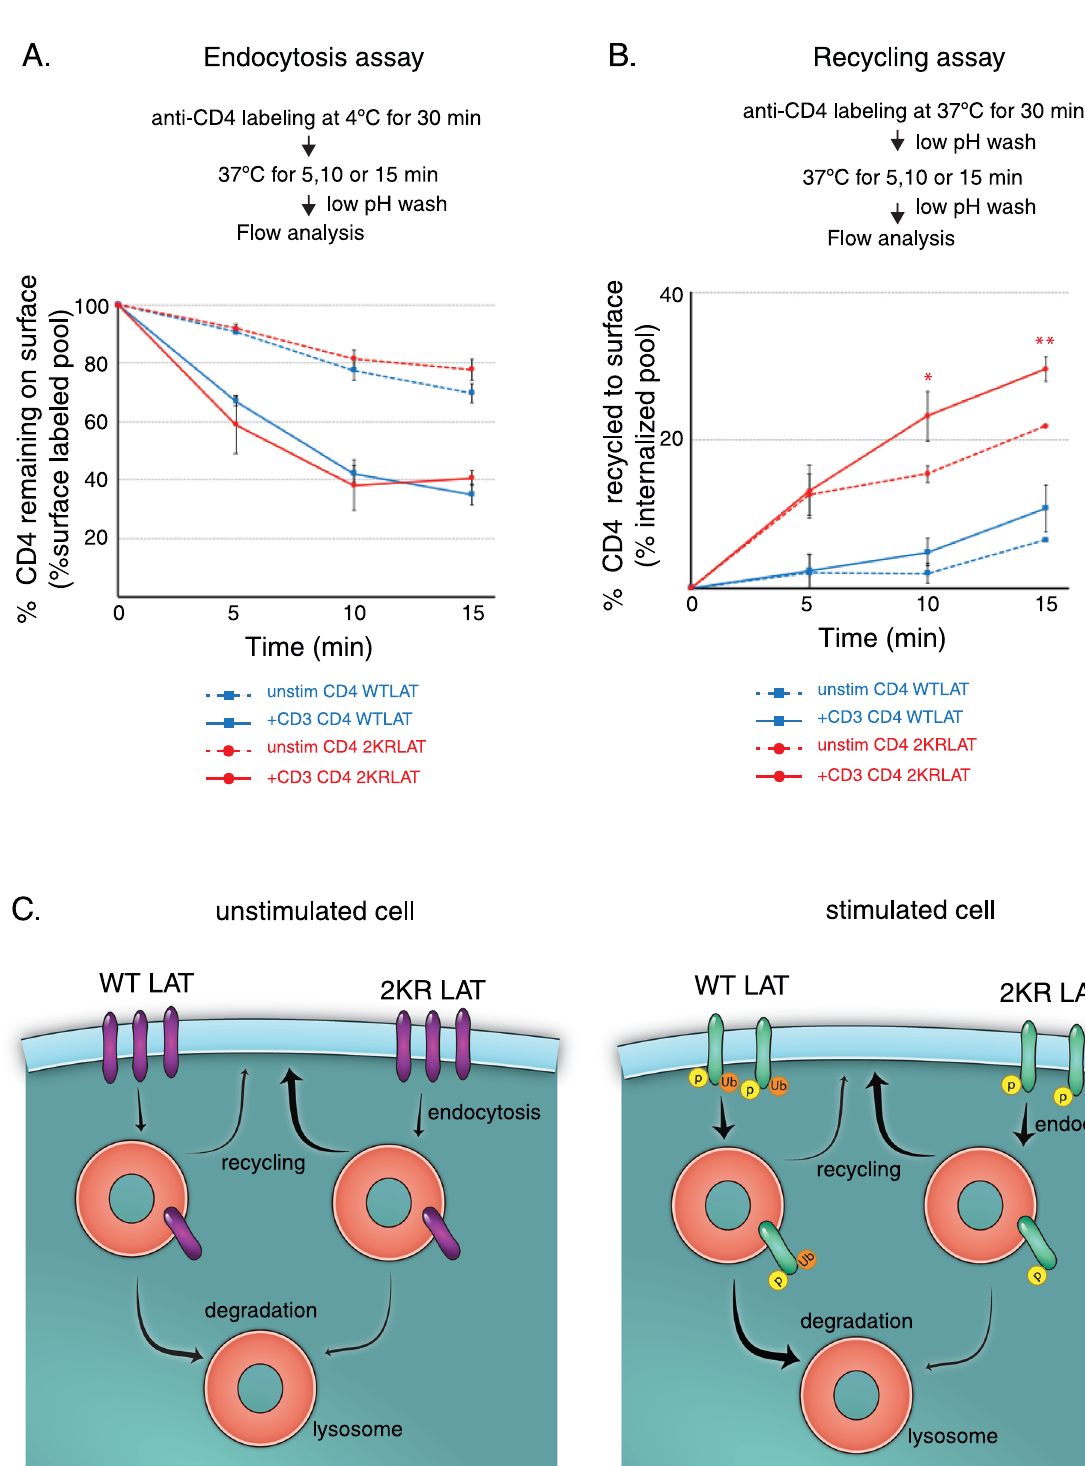
Fig 3. Endocytosis rates of CD4-WTLAT and CD4-2KRLAT are similar, but 2KR recycles at higher rates. A . JCam2.5 cells stably expressing CD4-WTLAT or CD4-2KRLAT were labeled with anti-CD4 (clone OKT4) at 4˚C. Cells were transferred to 37˚C for indicated times. Cells were washed with low pH buffer to remove surface CD4-LAT, anti-CD4 levels were measured by flow cytometry and endocytosis rates were calculated as described in Materials and Methods. Data is representative of three independent experiments. B . JCam2.5 cells stably expressing CD4-WTLAT or CD4-2KRLAT were labeled with anti-CD4 (clone OKT4) at 37˚C for 30 minutes to generate an internal pool. After a wash with low pH buffer to